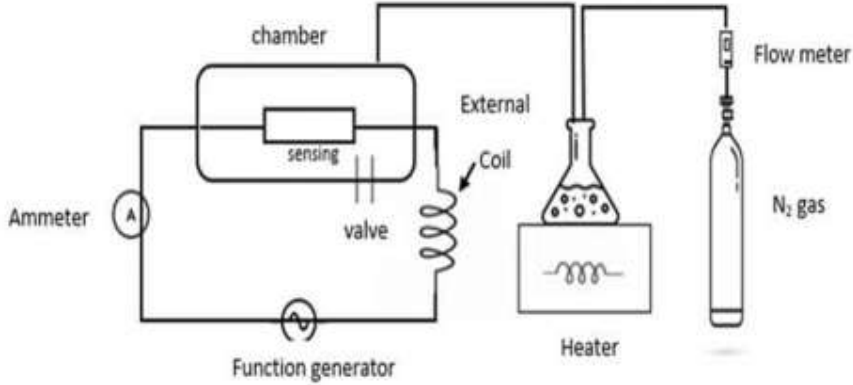
Figure 3: A schematic representation of organic and pesticide sensing measurements set –